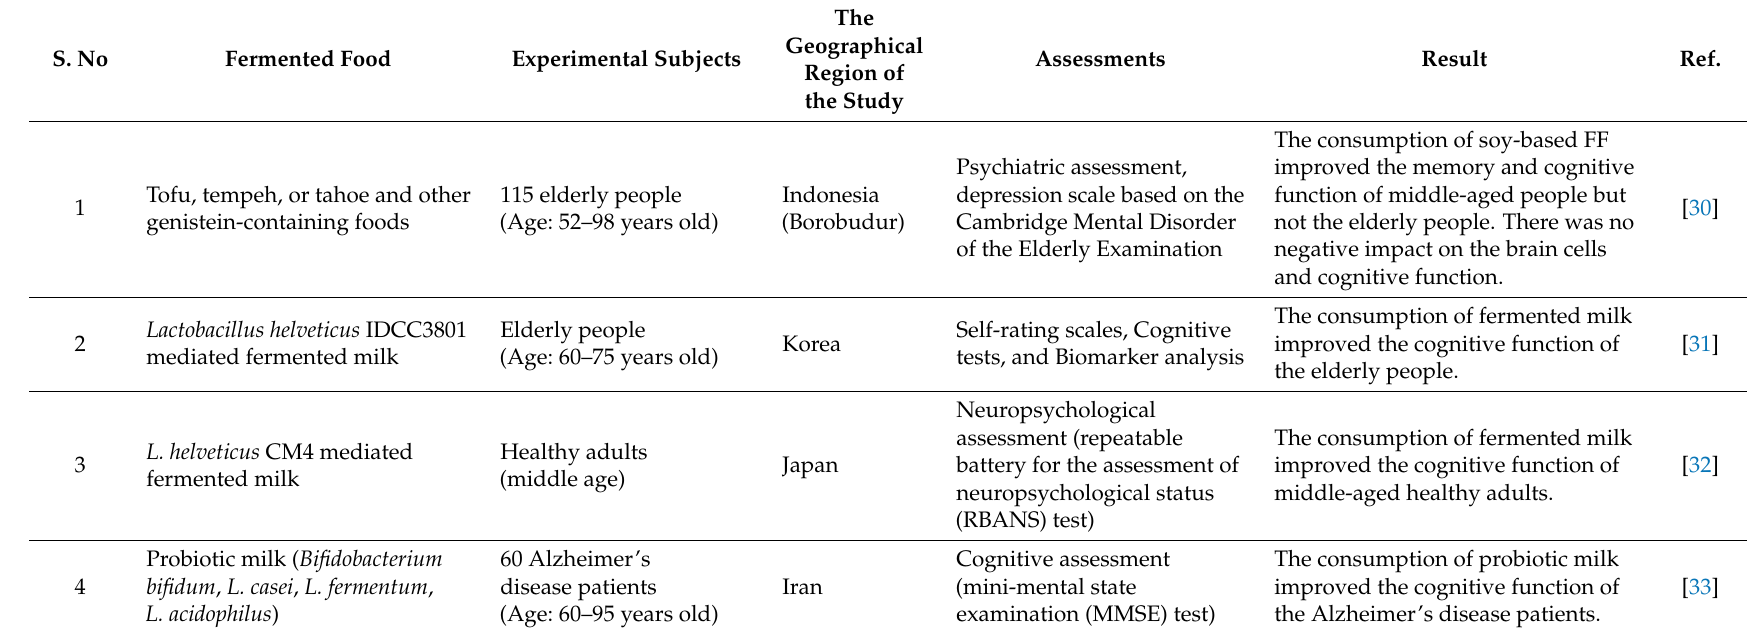
Table 1. Clinical outcome of fermented food (FF) supplementation on cognitive